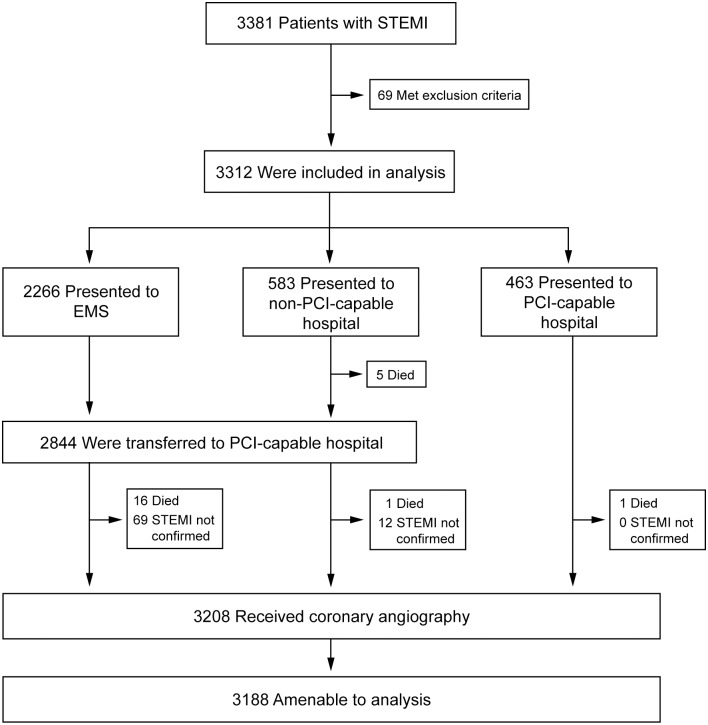
Enrollment and patient pathways.All patients with ST-segment elevation myocardial infarction (STEMI) recorded in the KIM registry were considered for inclusion in the analysis. Exclusion criteria included missing documentation of first medical contact. Analysis was done after stratification of patients according to FMC; patients presented to emergency medical services (EMS), hospitals with and without percutaneous coronary intervention (PCI) capability.